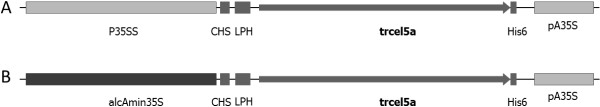
Schematic presentation of the plant expression cassettes for constitutive (A) and inducible (B) expression of TrCel5A. The CaMV promoter (P35SS) and terminator signal (pA35S) are indicated in light grey. The chimeric promoter (alcAmin35S) comprising the CaMV 35S minimal promoter (±31 to +5) fused to the upstream promoter sequences of alcA (Caddick et al., 1998) is shown in black. 5′-UTR of chalcone synthase (CHS), plant codon-optimized leader peptide (LPH) derived from the heavy chain of the murine mAb24, the gene of interest (trcel5A) and the His6 coding sequence (His6) are indicated in dark grey.